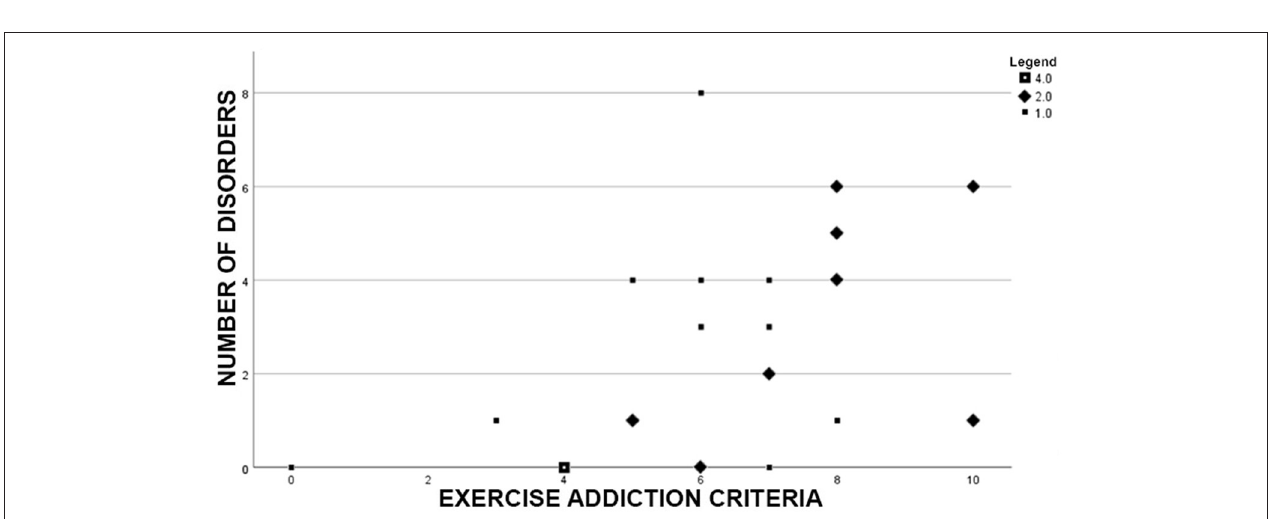
FIGURE 2 | Scatterplot of our sample ( n = 30) demonstrating the correlation between number of fulfilled exercise addiction criteria and number of disorders. Outliers exceeding two standard variations in number of disorders ( n = 2) were